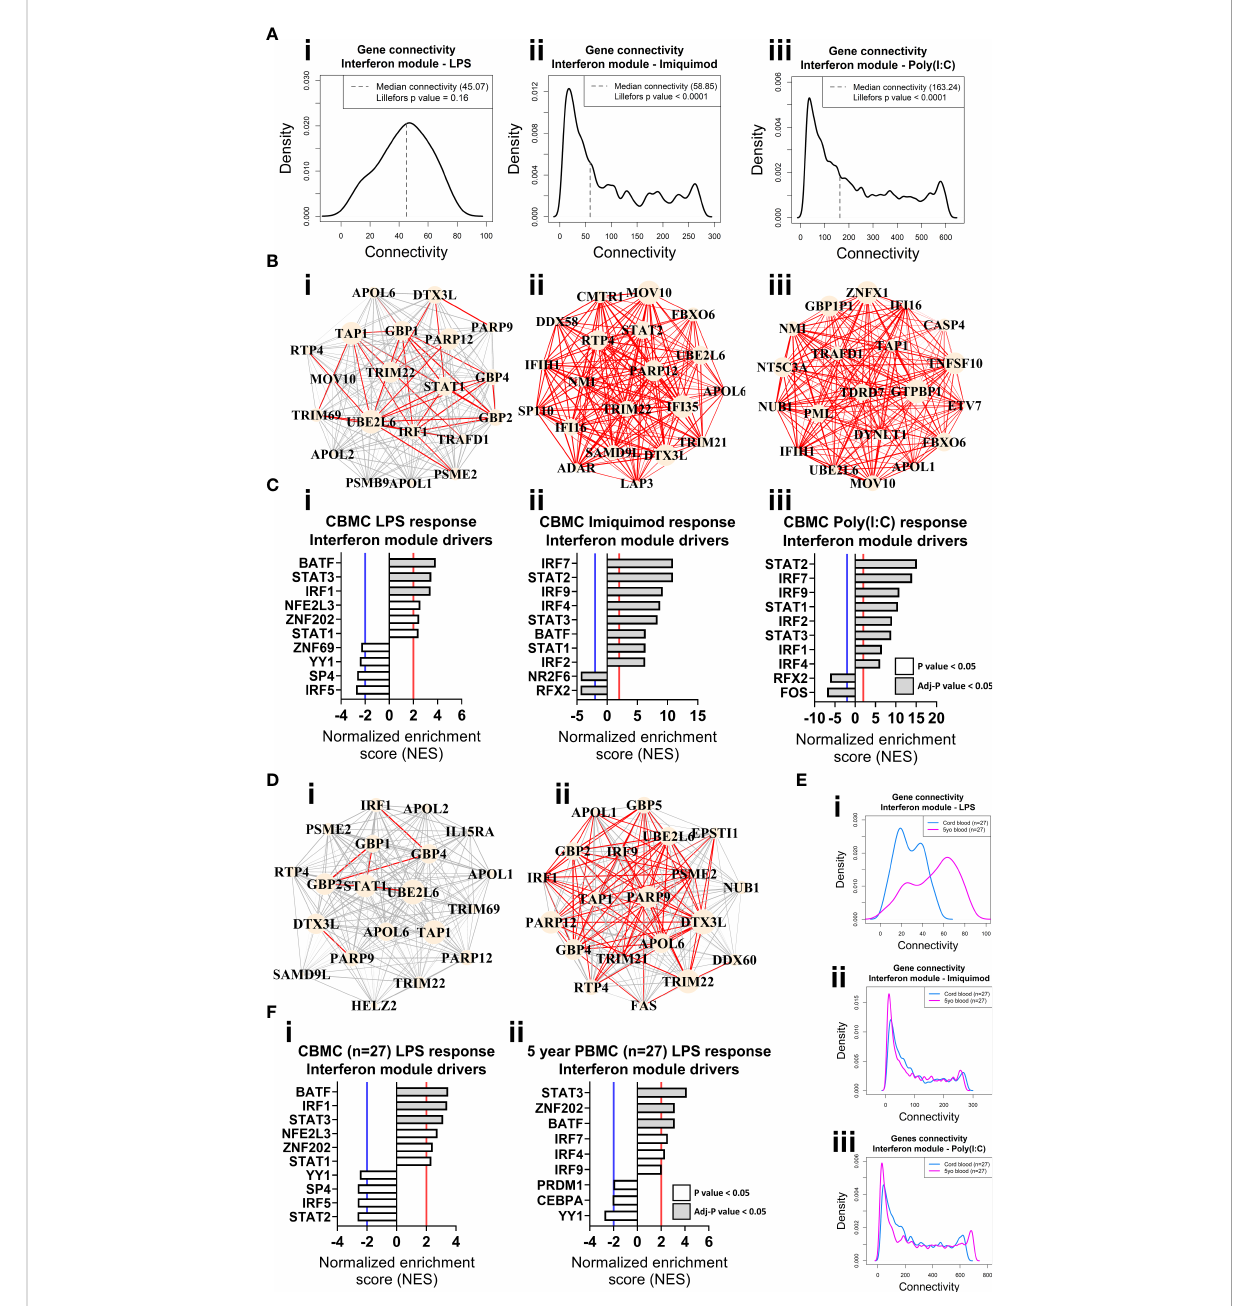
FIGURE 3 Network connectivity and master regulator analysis of IFN responses at birth and age 5 years identify IRF1 as a key driver. (A) Density plot of the LPS (i) , Imiquimod (ii) , and Poly(I:C) (iii) CBMC response IFN module connectivity, respectively. Dashed line denotes median. Lilliefors p value > 0.05 indicates normal distribution. (B) Network wiring diagrams of the top 20 most connected genes for the LPS (i) , Imiquimod (ii) , and Poly(I:C) (iii) CBMC IFN modules, respectively. Node size represents number of connections (degree) among the total network and edge width indicates strength of correlation (red edges > 0.8). (C) Top 10 master regulators for the respective CBMC IFN modules. Bar plots show normalized enrichment score (NES) for transcription factors which are signi fi cantly activated (NES>2, red line) or inactive/inhibited (NES<-2, blue line). Grey shading indicates an adjusted P value < 0.05. (D) Network wiring diagrams of the most connected CBMC LPS-induced IFN module genes from matched CBMC (i) and 5 year PBMC (ii) samples. Network characteristics are the same as above (B). (E) Network connectivity density plot for the interferon module gene connectivity of the matched CBMC (blue) and 5 year PBMC (magenta) responses to LPS (i) , Imiquimod (ii) , and Poly (I:C) (iii) stimulation. (F) Top drivers of the LPS-induced interferon module genes identi fi ed for matched CBMC (i) and 5 year PBMC ( ii , 9 drivers were signi fi cant at P <0.05 samples. Bar plot characteristics are the same as above (C)